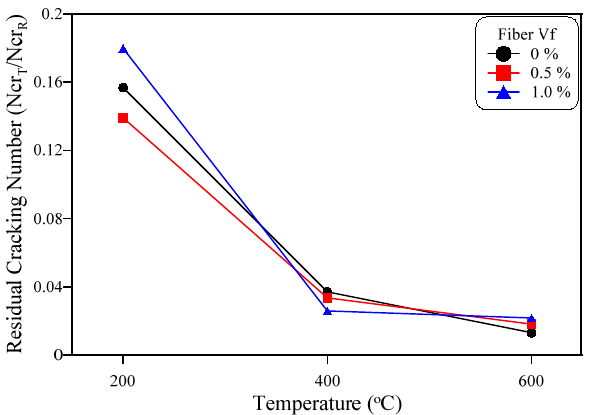
Figure 12. Residual cracking impact number after high-temperature exposure.